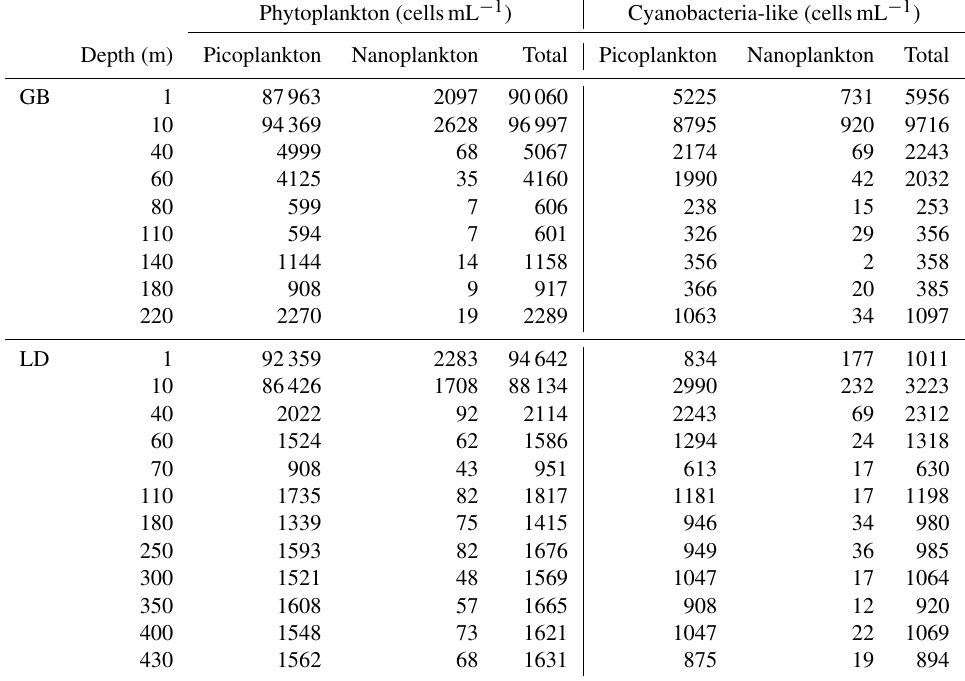
Table 2. Abundance of chlorophyll- and phycoerythrin-containing picoplankton and nanoplankton measured by flow cytometry in GB and